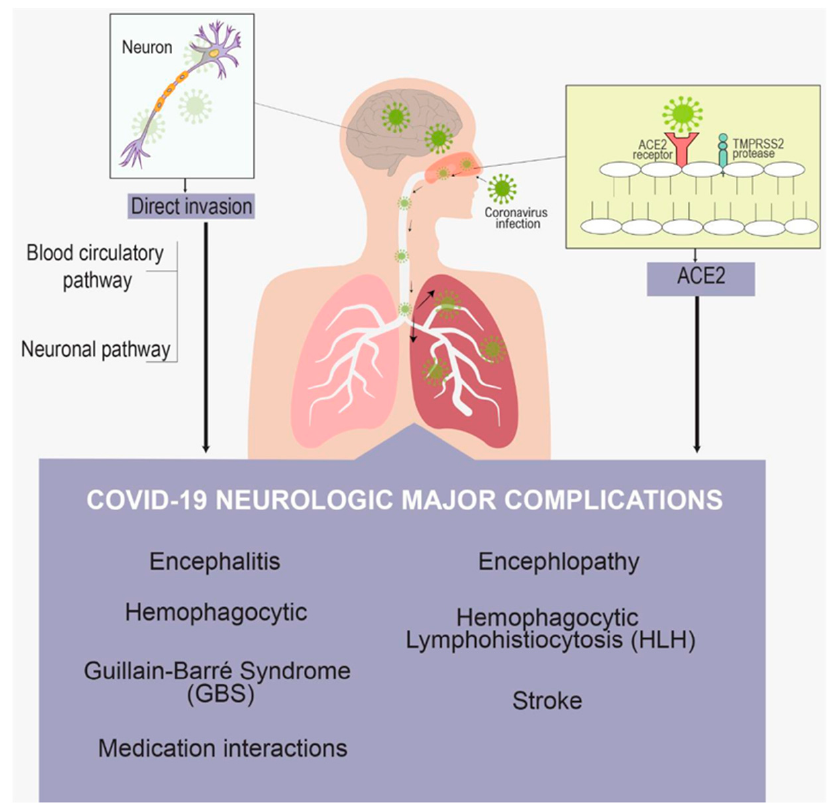
Figure 4. Neurologic major complications of COVID-19.